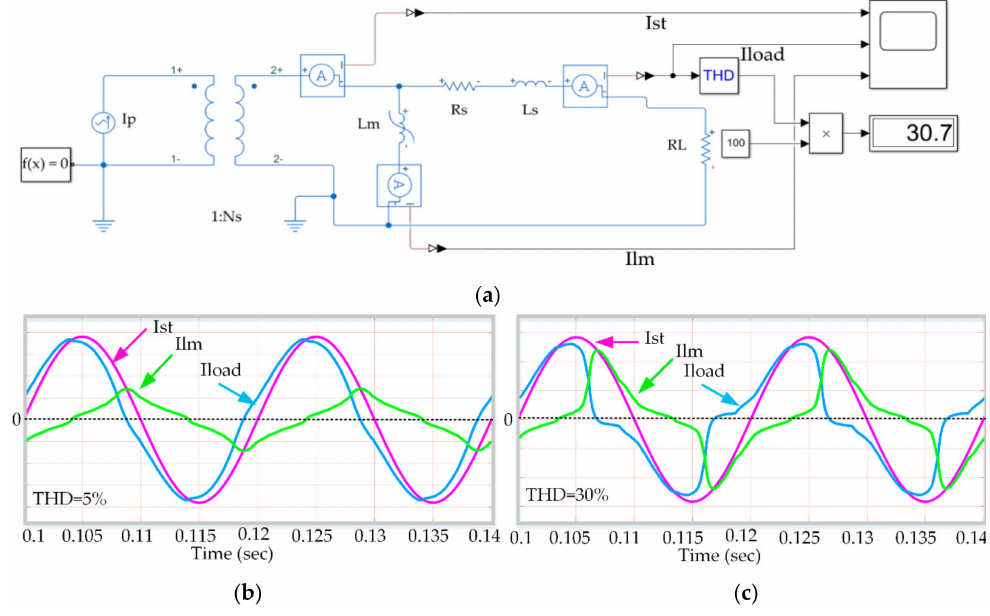
Figure 4. ( a ) Experimental setup for saturation characterization. ( b,c ) Saturated